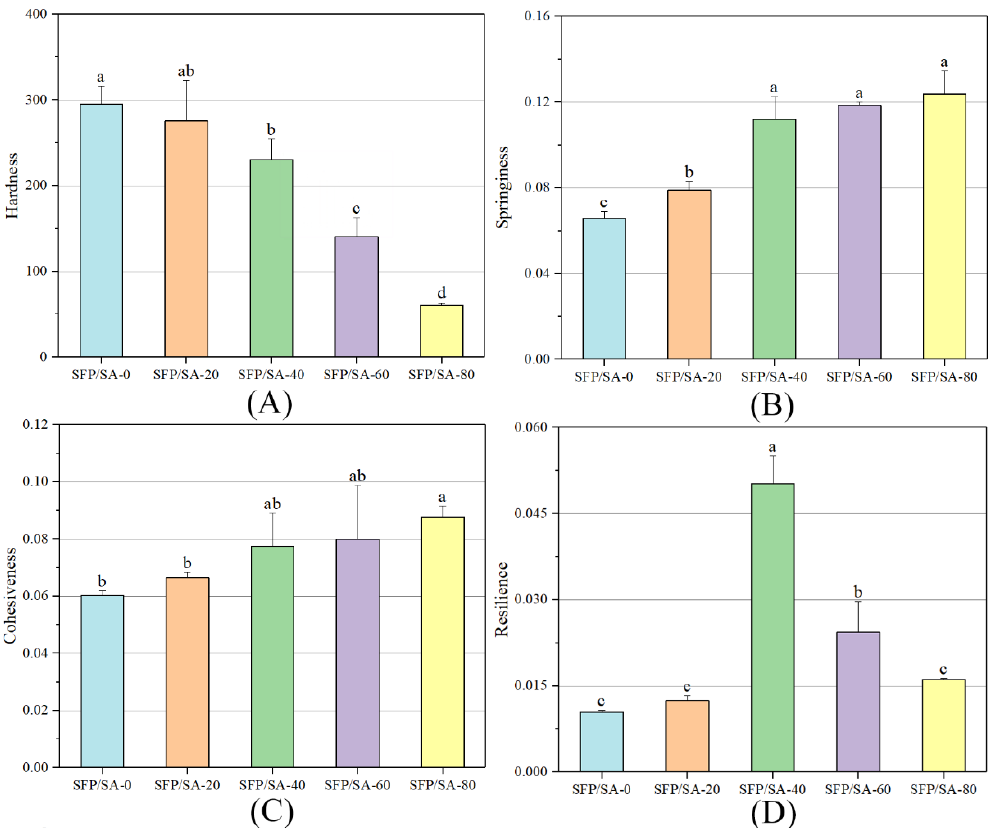
Figure 4. The TPA diagram about SFP/SA hydrogel microspheres of hardness ( A ), springness ( B ), cohesiveness ( C ) and resilience ( D ). Differences between means with the same exponent letter are not significant at a p -level value < 0.05.